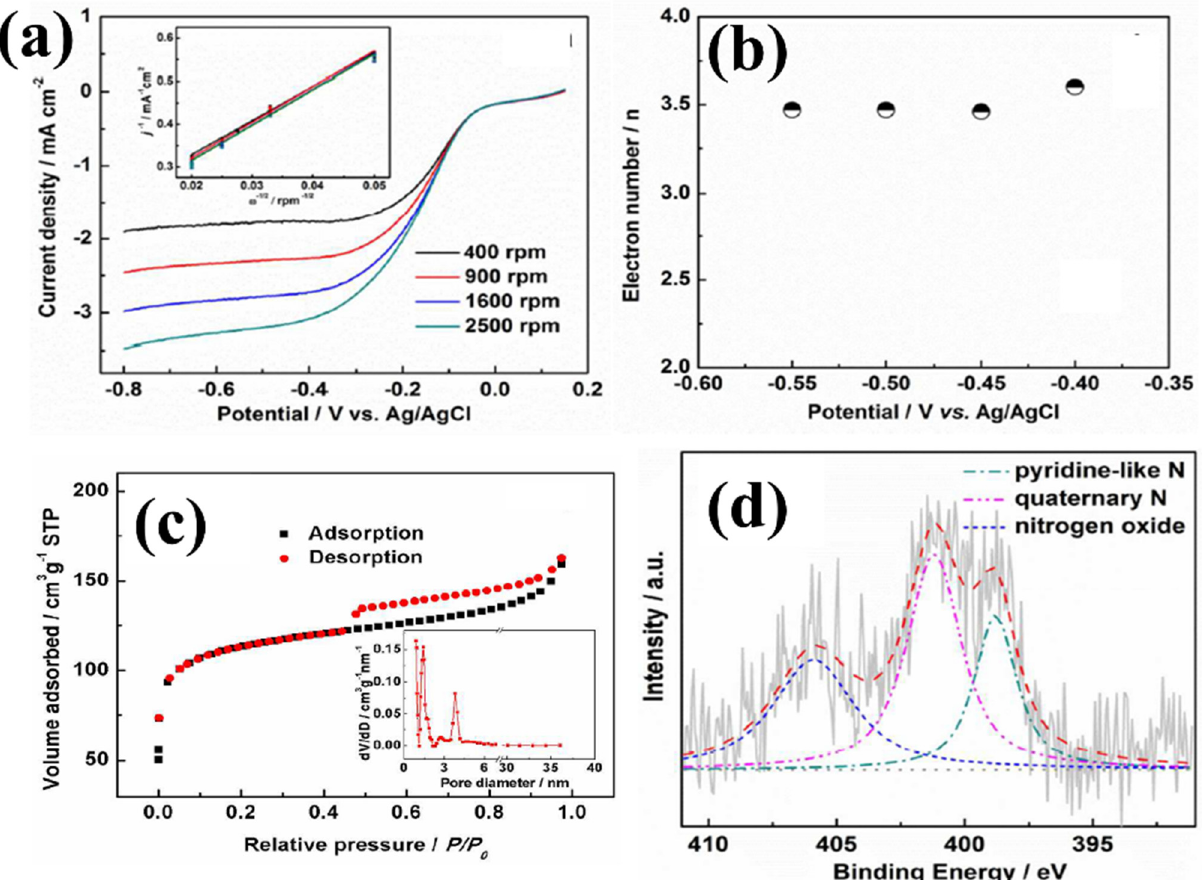
Figure 5. ( a ) LSVs for ORR in O 2 –saturated 0.1 mol L –1 KOH solution on CFB at various rotation rates, scan rate 5 mV s –1 ; (Inset: the corresponding K–L plots for ORR), ( b ) the number of transferred electrons at a different potential, ( c ) N 2 adsorption-desorption isotherms of CFB (Inset shows the corresponding pore size distribution), ( d ) High–resolution XPS spectrum at N1s region of CFB, adapted from [52].